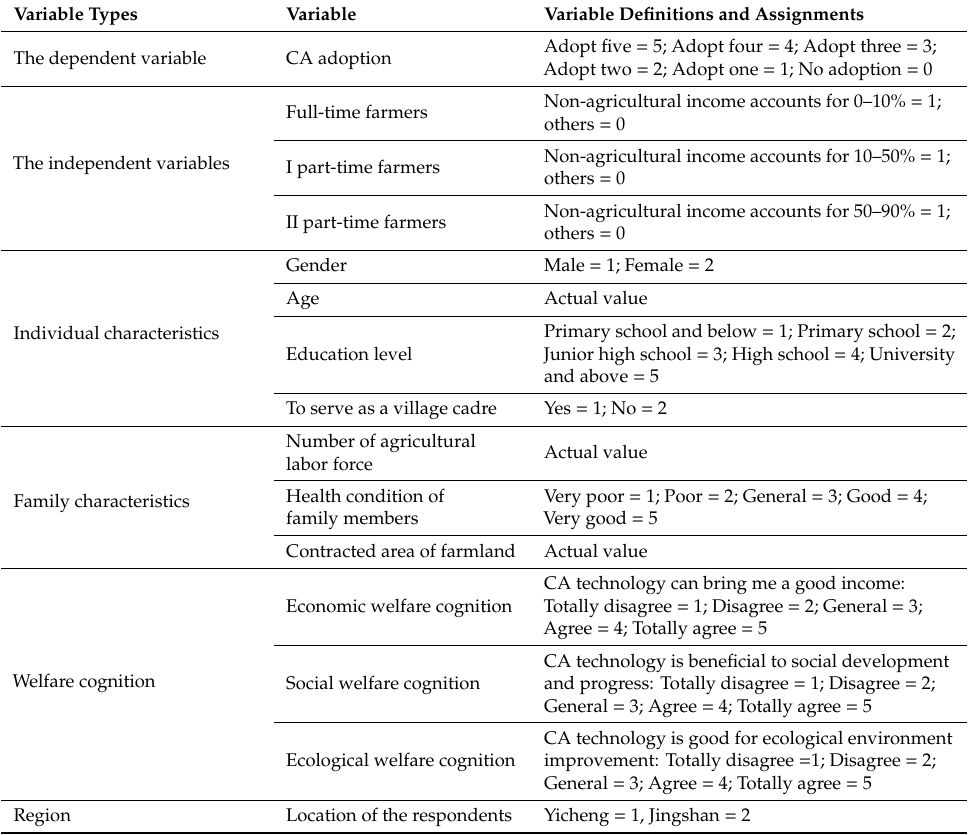
Table 1. Variable definition and